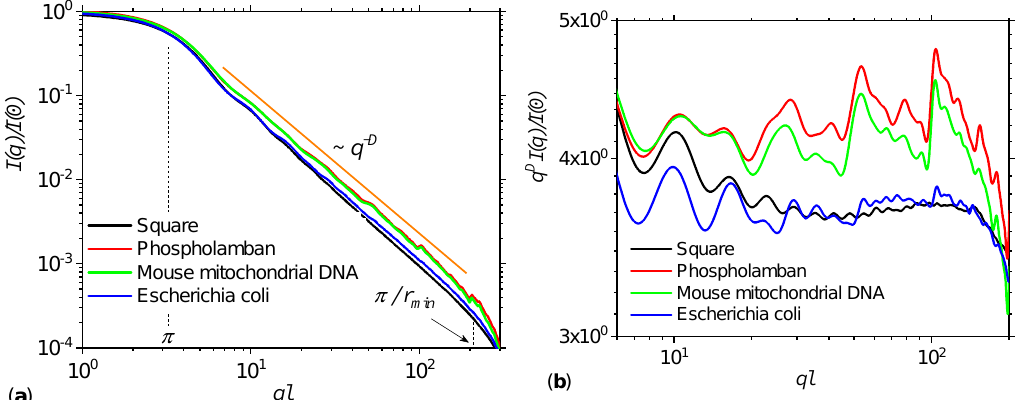
Figure 11. Scattering intensities I ( q ) ( a ) and q D I ( q ) ( b ) of Phospholamban (red), Mouse mitochondrion DNA (green), and Escherichia coli (blue). For comparison, the scattering intensity of a uniform distribution of points within a square is shown. l is the overall size of the “ACGT” square, r min is the minimum scale on which the samples have a fractal behavior, and D is the fractal dimension (see text for